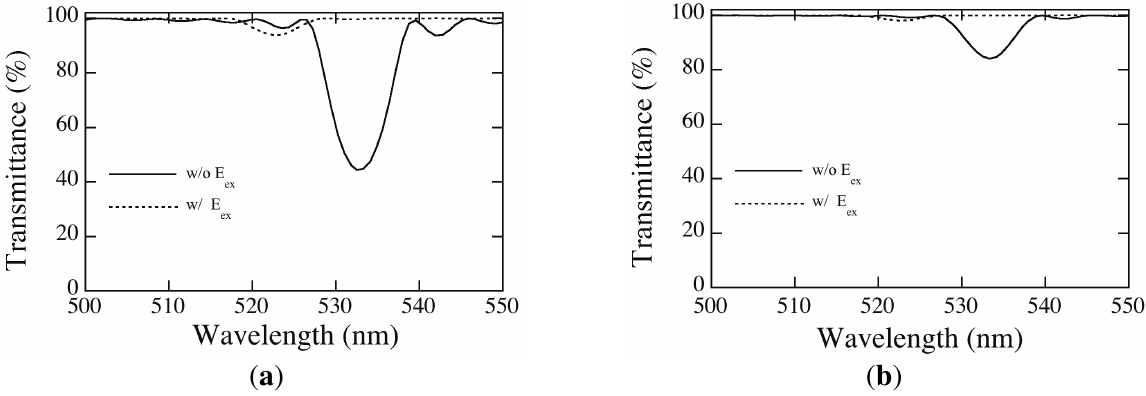
Calculated spectral transmittances of an HPDLC film recorded by three p-polarized plane-wave interference holographic polymerization and readout by normally incident ( a ) s and ( b ) p waves without and with E ex